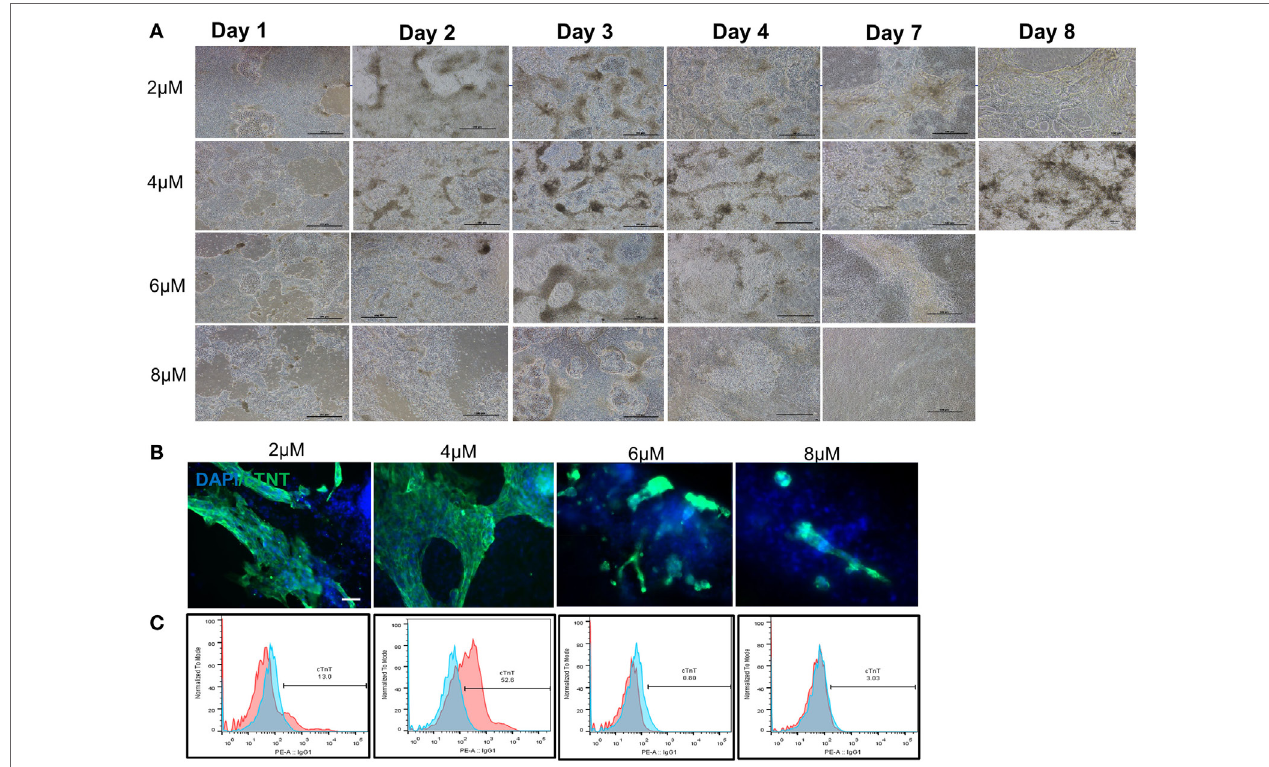
FigUre 3 | Optimization of cardiomyocyte differentiation through modulation of CHIR99021 concentration. (a) Morphology of LiPSC 18R-derived differentiated cells was changed enormously during the first week of directed differentiation. The cells with 8 µM of CHIR resulted in lots of cell death and empty spaces with no beating area observed. Dark brownish areas are representative of cardiac beating patches. (B) Immunofluorescent staining of differentiated cells for cardiomyocyte specific marker cardiac-specific troponin (cTnT) demonstrated that 4 µM of CHIR99021 resulted in higher number and bigger beating areas among the four conditions tested. (c) Flow cytometry for cTnT also confirmed the higher number of cardiomyocytes in the 4-µM condition (pink: target, blue: isotype). Scale bar: 100